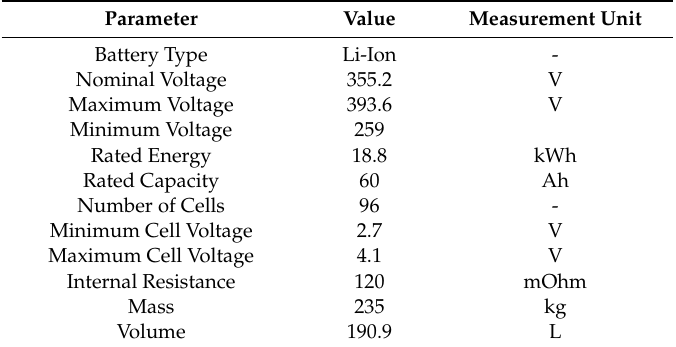
Table A3. Parameters of the EV battery.